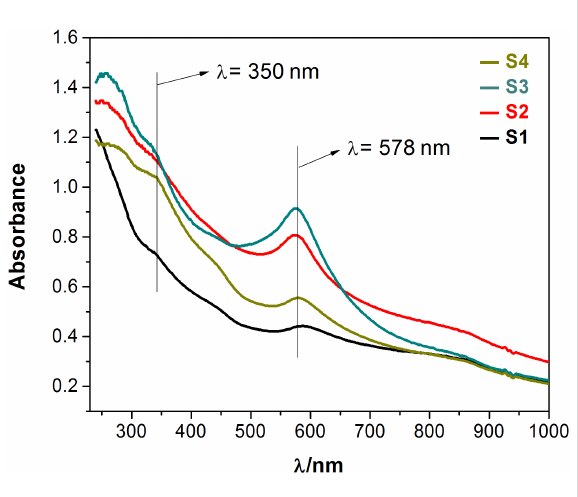
Figure 5: UV–vis–NIR absorption spectra of the various prepared